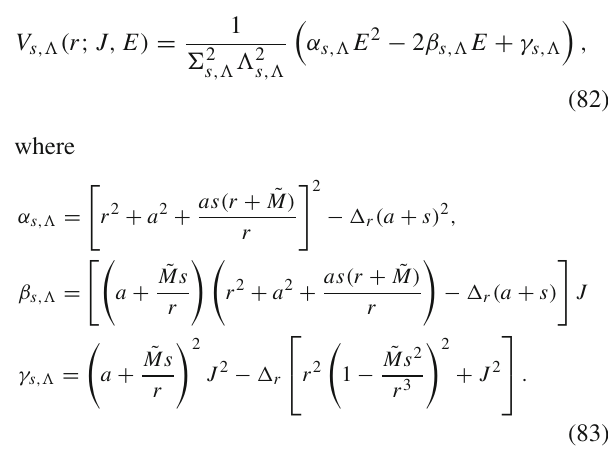
Fig. 9 ISCO radius in term of L for co-rotating test body, with a / M = 0 . ISCO does not exist